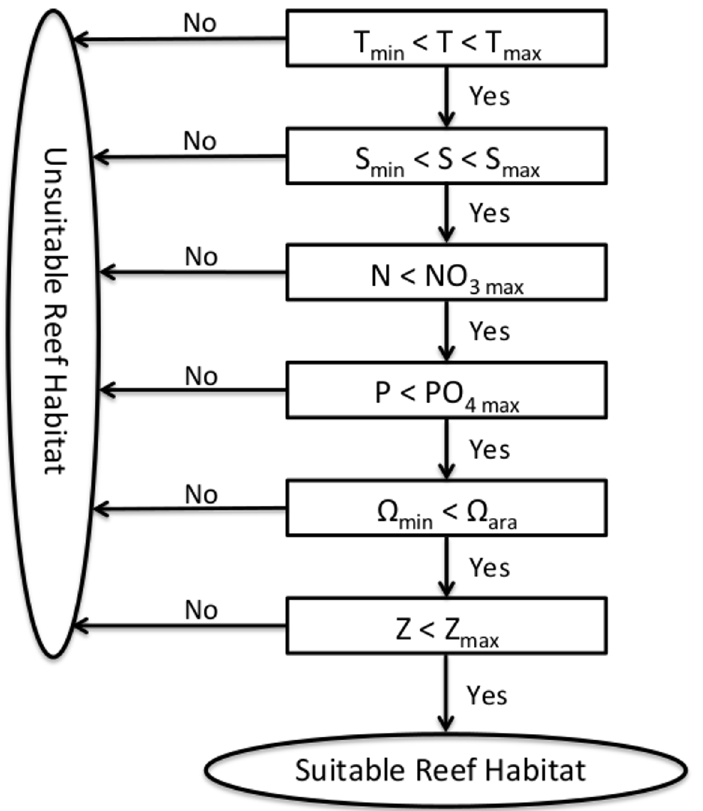
Fig 1. Flow chart of the ReefHab diagnostic model, modified from Kleypas